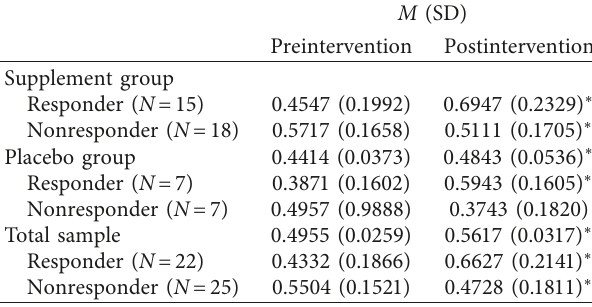
Table 4: Treatment response–change in MPOD concentrations.